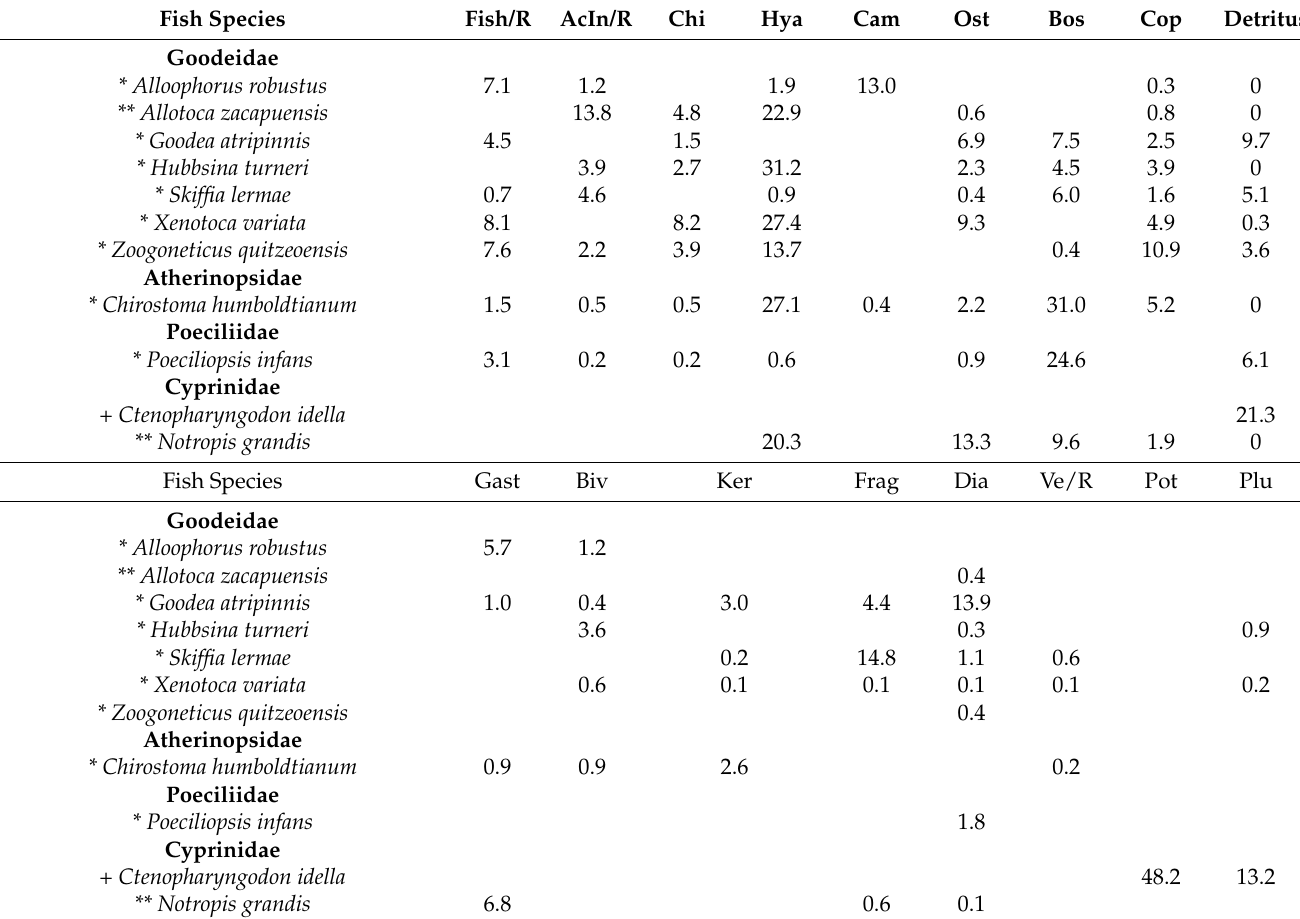
Table 2. Diet and trophic classification of fish species sampled in Lake Zacapu. The values for each item type and fish species represent the Variation in the Prey-Specific Index of